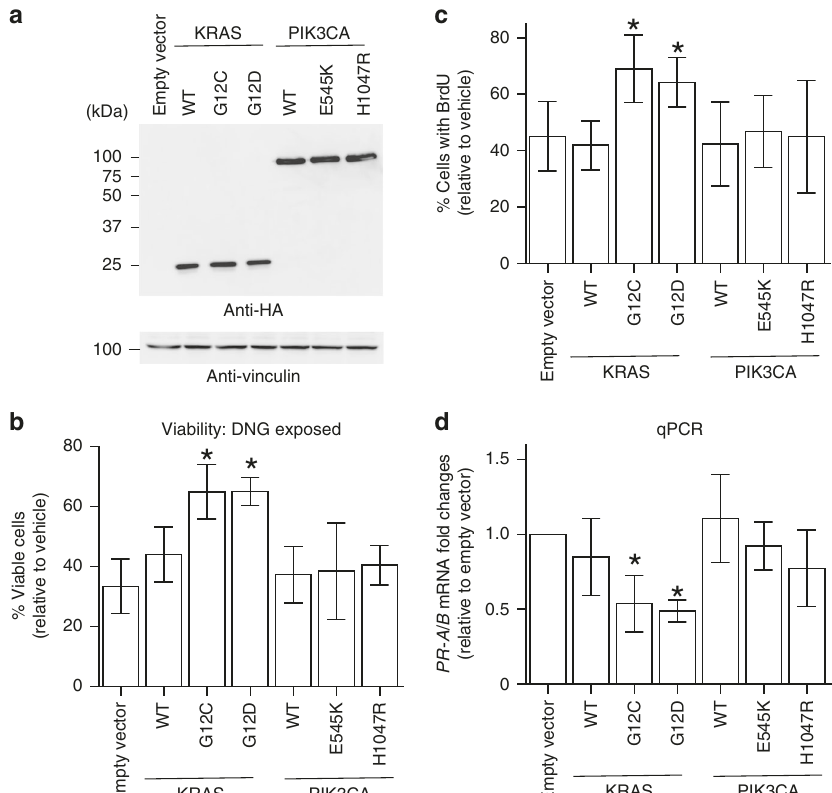
Fig. 6 Mutant KRAS expression abrogates the progestin-induced anti-proliferative effect of DNG through downregulation of PR . a Immunoblotting to detect ectopically expressed, HA-tagged wild-type (WT) KRAS and PIK3CA, or KRAS or PIK3CA bearing the indicated amino acid substitutions, in immortalized human uterine epithelial cells. Vinculin, loading control. Viability ( b ) and proliferation ( c ) of WT immortalized uterine endometrial epithelial cells or those overexpressing the indicated mutations of KRAS or PIK3CA . b Cells were exposed to 1 μ M DNG or vehicle (DMSO) for 72 h. Results are the percentage of viable cells relative to vehicle control cells. Data are the mean + SD of six independent experiments, each with three technical replicates per group. * p < 0.05 by Welch ’ s t -test. c Cells were exposed to 1 μ M DNG or vehicle (DMSO) for 48 h. Results are the percentage of BrdU + cells relative to vehicle control cells. Data are the mean + SD of four independent experiments per group without technical replicates. * p < 0.05 by Welch ’ s t -test. d Quantitative RT – PCR determination of mRNA levels of PR - A/B in the immortalized cells in a . Values were normalized to GAPDH . Data are the mean fold change + SD relative to levels in control cells stably infected with empty vector. Six independent experiments, each with three technical replicates per group, were conducted. * p < 0.05 by Welch ’ s t -test. Source data are provided as a Source Data fi